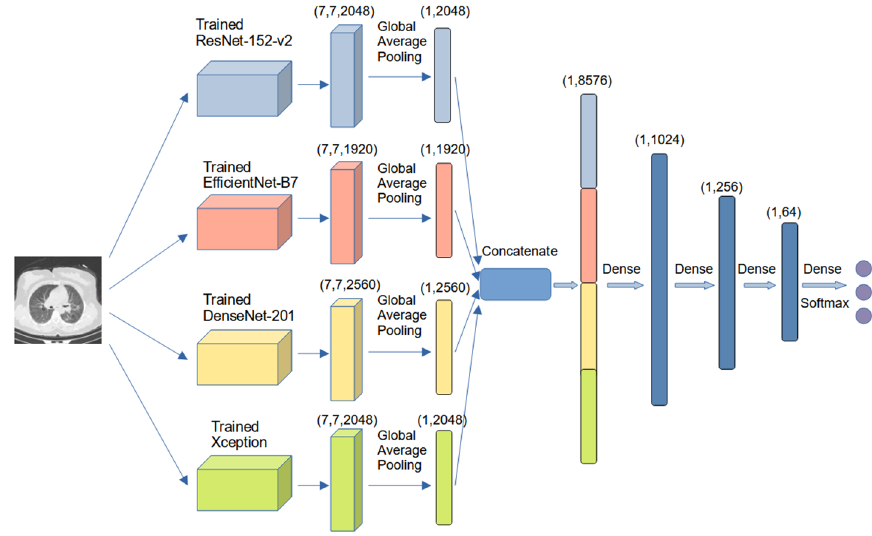
Figure 10. NN Ensemble CNN Model.